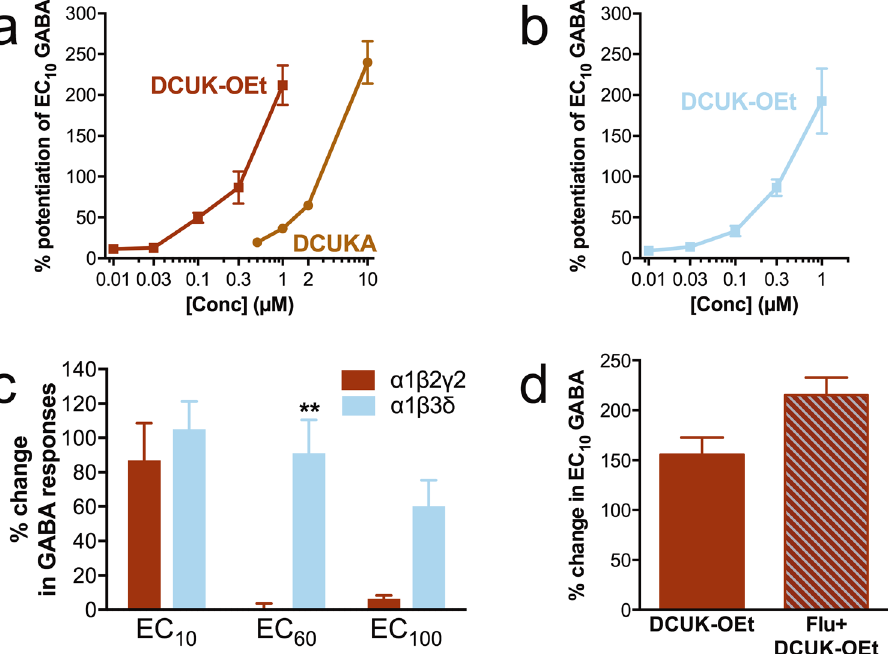
Figure 2. DCUK effect on GABA responses. ( a ) Effect of DCUK compounds on submaximal (EC 10 ) GABA responses of α 1 β 2 γ 2 GABA A receptors (n = 4–5 at each concentration of DCUK compound). ( b ) Effect of DCUK-OEt on submaximal (EC 10 ) GABA responses of α 1 β 3 δ GABA A receptors (n = 5–6 at each concentration of DCUK-OEt). ( c ) Effect of DCUK-OEt (0.3 µ M) and escalating GABA concentrations applied to α 1 β 2 γ 2 and α 1 β 3 δ GABA A receptors (n = 9 each). GABA concentrations used: 3 and 1 µ M for α 1 β 2 γ 2 and α 1 β 3 δ , respectively (~EC 10 ); 30 µ M (~EC 60 ); 3 mM (~EC 100 ). ( d ) DCUK-OEt (0.3 μ M) effect in the absence and presence of 20 μ M flumazenil (Flu) (n = 5 for each condition). Data represent mean ± SEM. ** p < 0.01 compared to α 1 β 2 γ 2 (one-way ANOVA and post-hoc